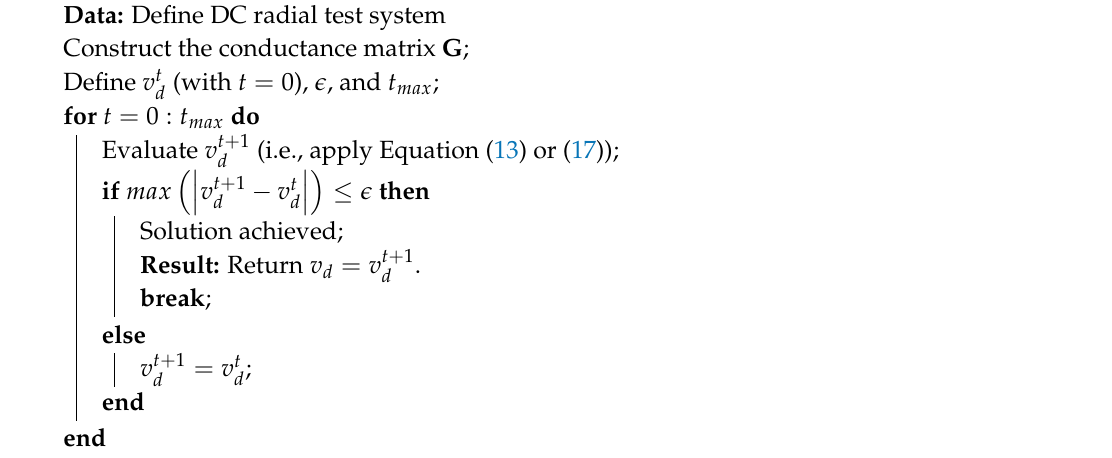
Algorithm 1: Iterative power-flow method for direct-current (DC) resistive networks with radial or mesh